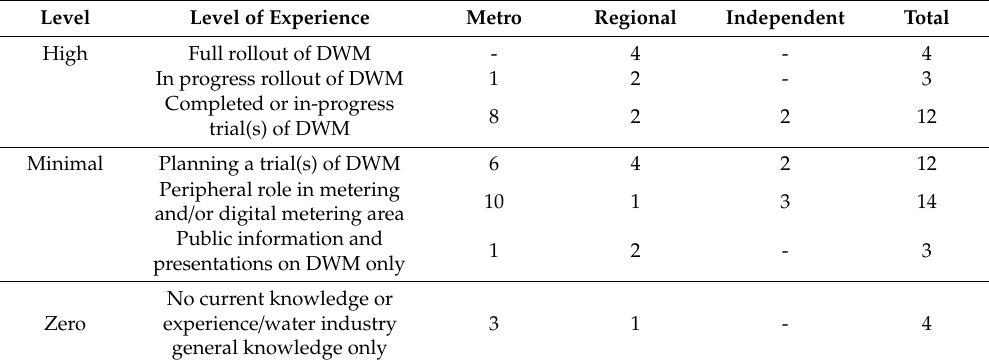
Table 3. Level of experience with DWM by organisation